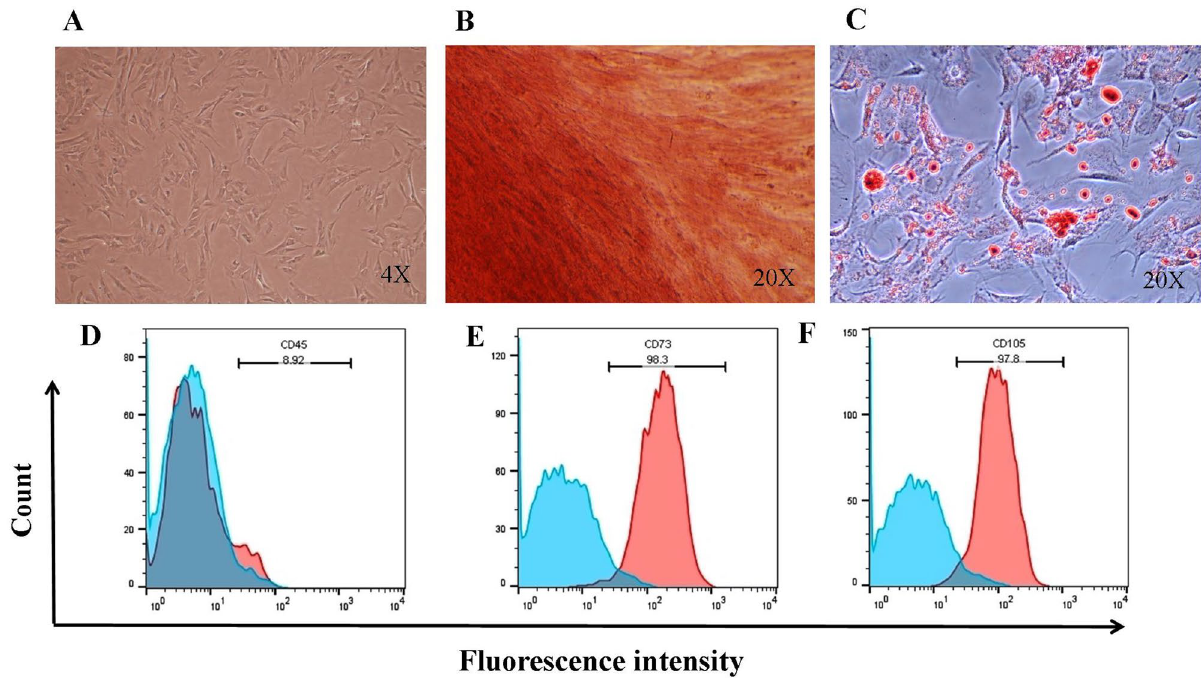
Figure 1. Characterization of hUCSCs. hUCSCs displayed adherent and fibroblast-like morphology ( A ). Alizarin red staining for osteogenic differentiation ( B ) and Oil red O staining for adipogenic differentiation ( C ). hUCSCs were analyzed for specific surface markers by flow cytometry, which confirmed lack of CD45 ( D ) and the expression of CD73 ( E ), CD105 ( F ). hUCSC human umbilical cord mesenchymal stem